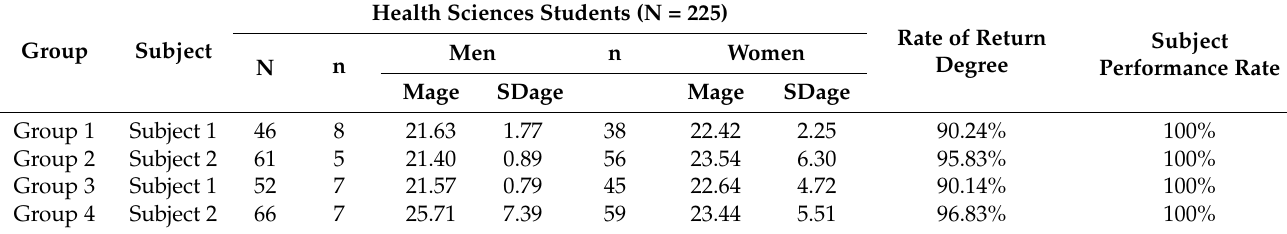
Table 2. Descriptive statistics for the sample of